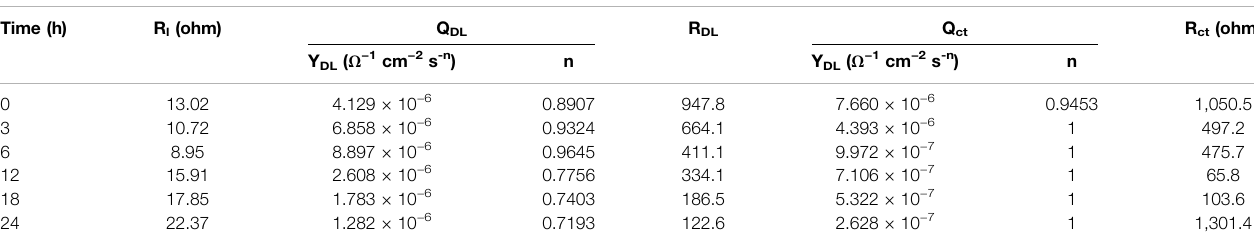
TABLE 2 | Fitted data by Zsimpwin of EIS results.